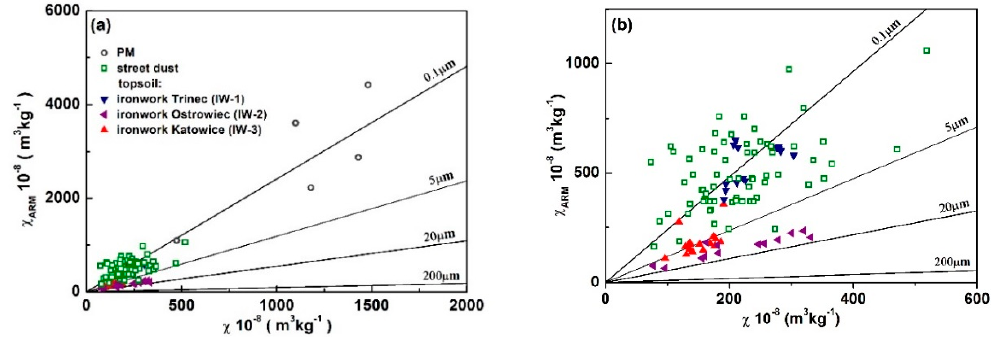
Figure 10. King’s plot of χ ARM versus χ for the topsoil samples (King et al., 1982) [59] ( a ) and ( b ).